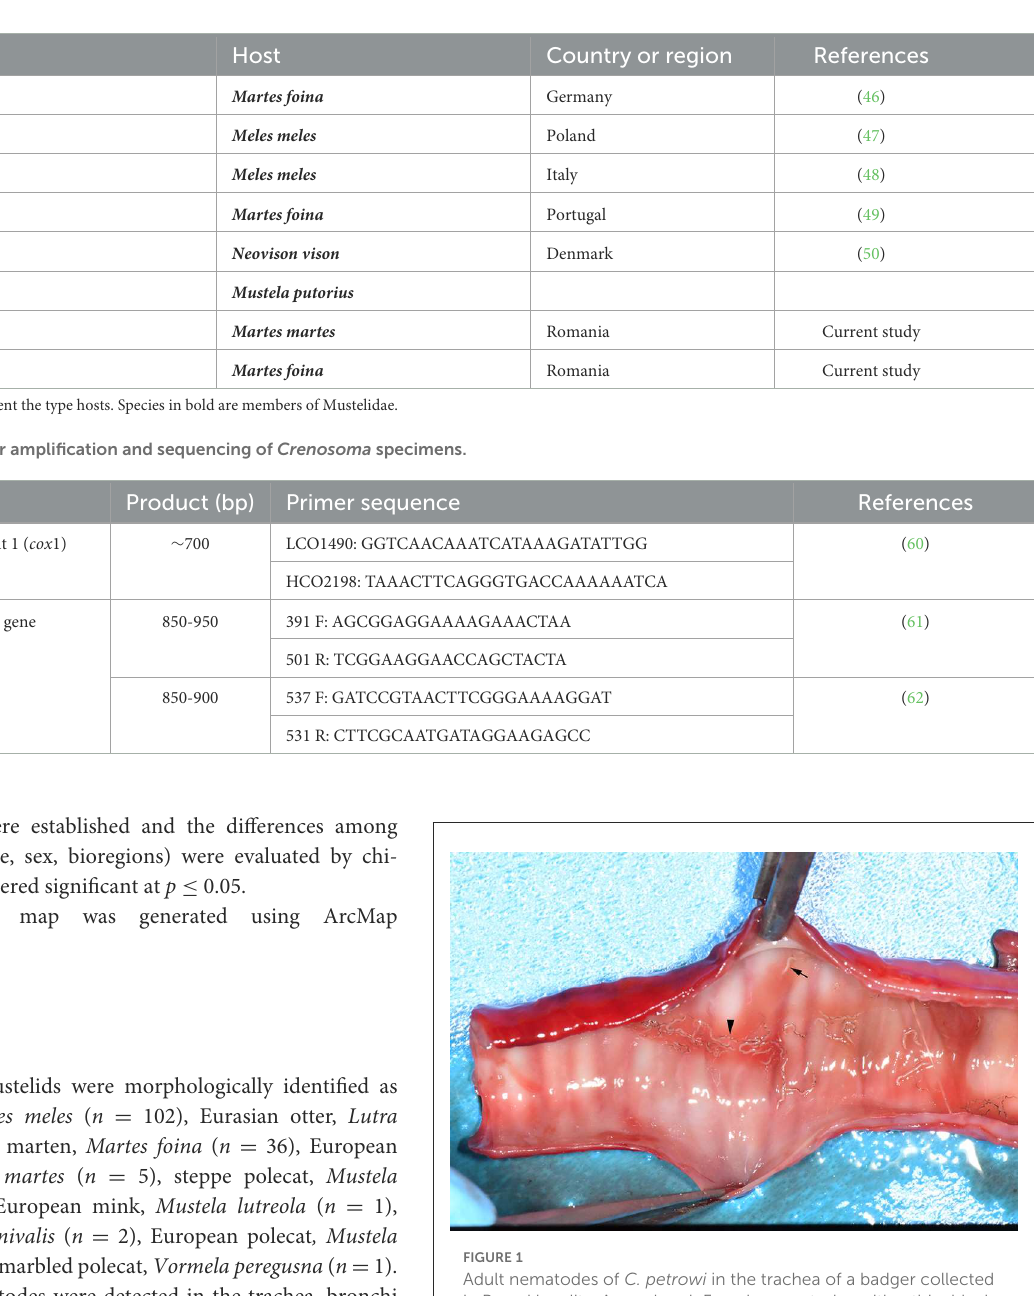
Adult C. melesi presented specific circular folds visible